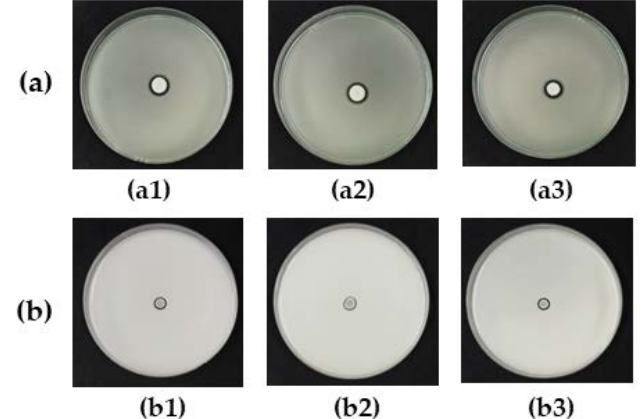
Figure4. Solubilizationof( a )phosphateonPikovskaya’sagarand( b )zincoxideonzincoxideagarincubated Figure 4. Solubilization of ( a ) phosphate on Pikovskaya’s agar and ( b ) zinc oxide on zinc oxide agar for 5 days by antagonistic yeasts (a1,b1) Wickerhamomyces anomalus DMKU-CP122; (a2,b2) W. anomalus incubated for 5 days by antagonistic yeasts (a1, b1) Wickerhamomyces anomalus DMKU-CP122; (a2, b2) DMKU-CP127; and (a3,b3) W. anomalus W. anomalus DMKU-CP127; and (a3, b3) W. anomalus YE-42.